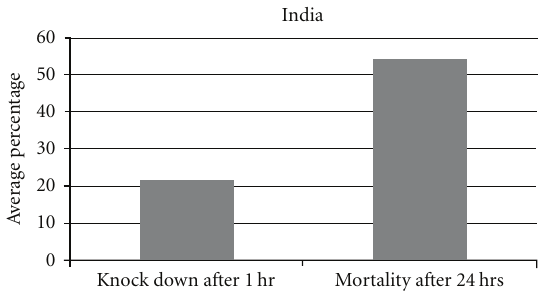
Figure 5: Susceptibility test for DDT in